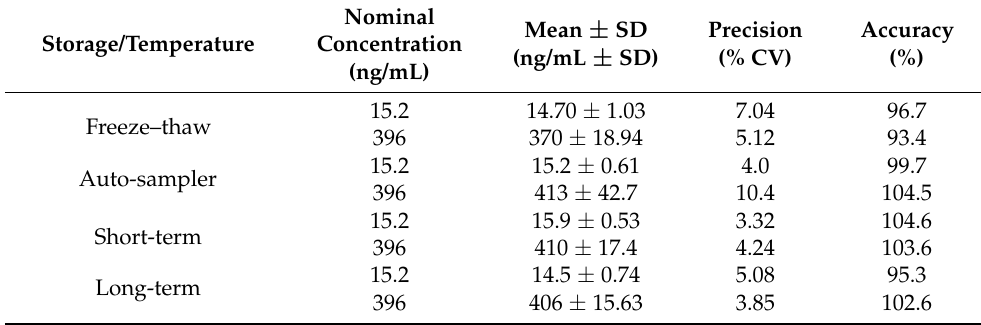
Table 3. Stability of trastuzumab under different temperature and storage conditions.